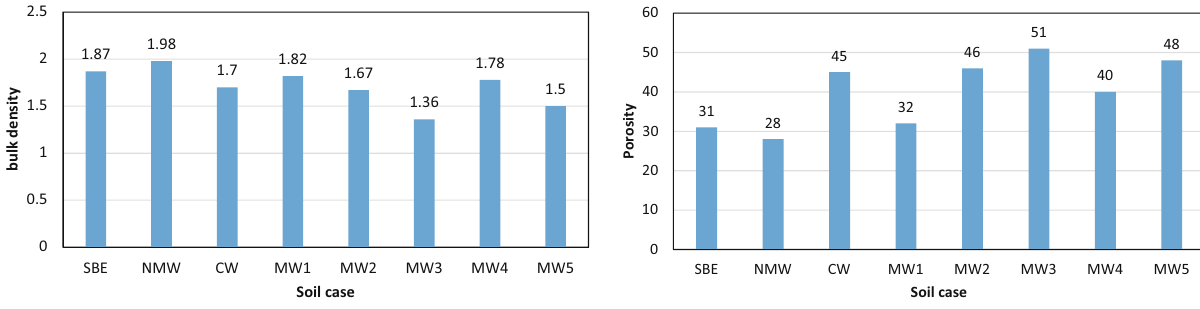
Figure 3: Bulk density of the soil.